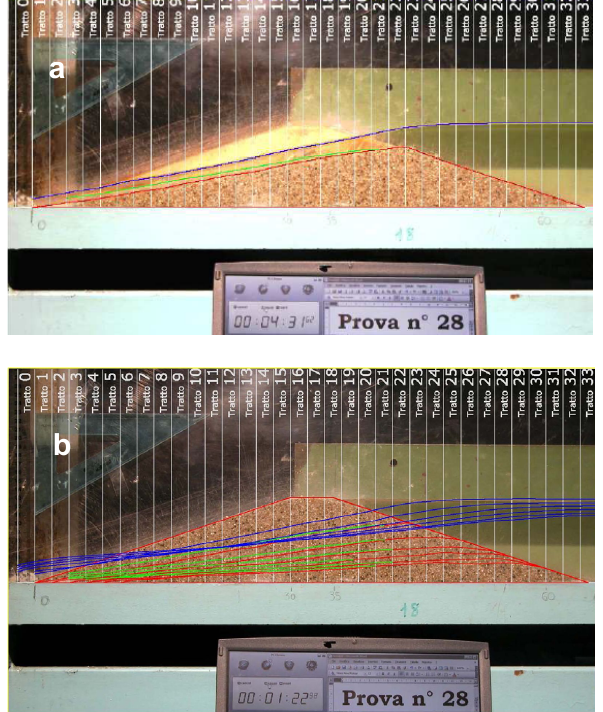
Fig. 11. Third stage – embankment lateral picture. (a) Example of picture analysis during the third stage: water profile (blue), bed pro- file (red) and moving layer profile (green) are drawn on the picture. (b) Example of evolution in time of bed, flow and moving layer profiles.